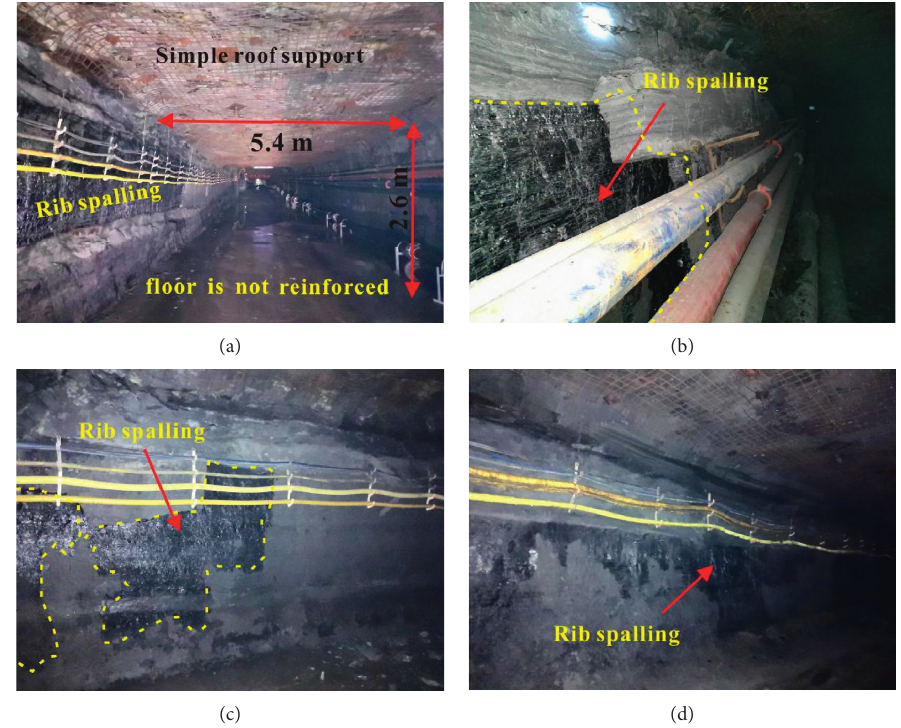
Figure 3: Roadway size and failure characteristics of the surrounding rock.